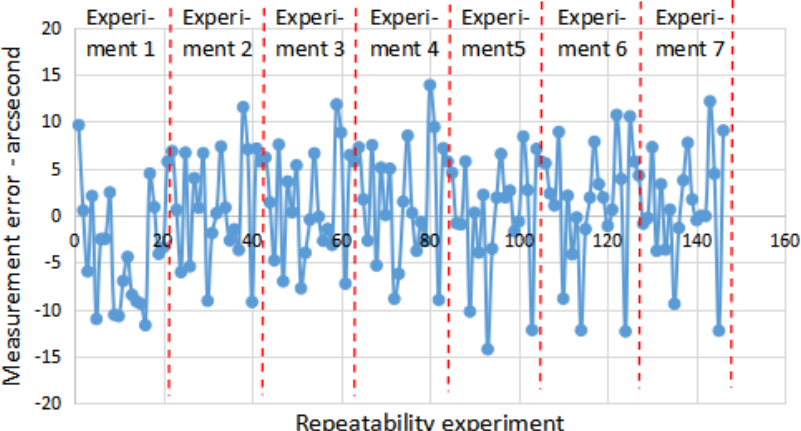
Figure 28. Error distribution after compensation.